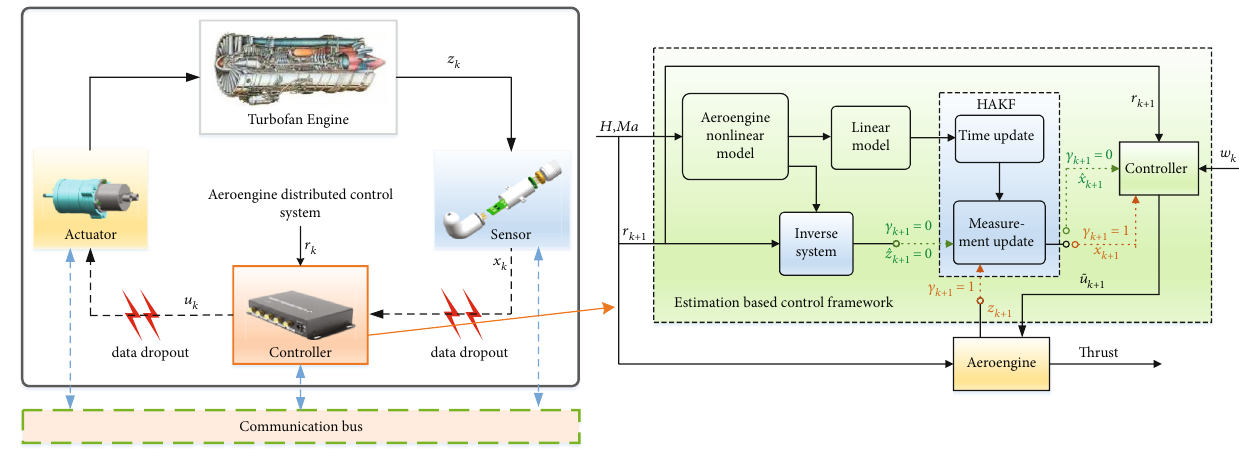
Figure 1: Framework of aeroengine DCS with estimation-based control